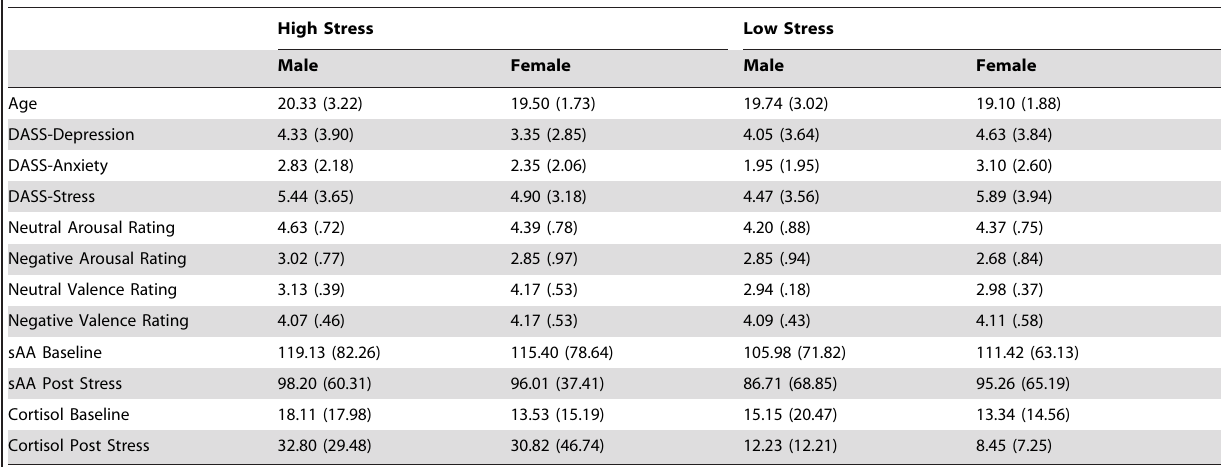
Table 1. Participant Characteristics and Stress Responses.